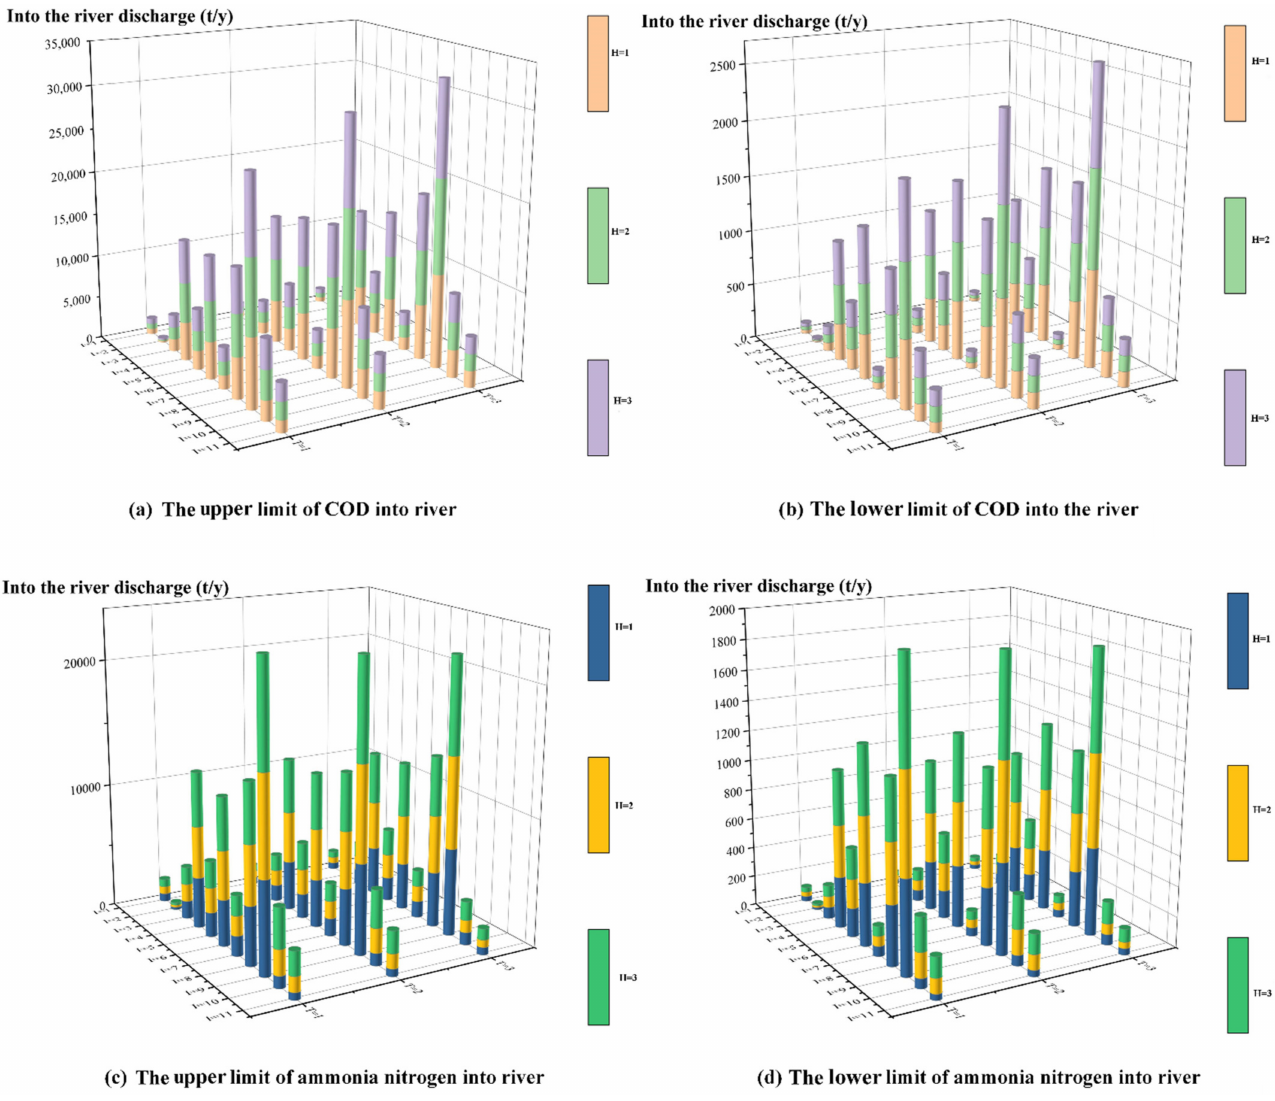
Figure 3. COD and ammonia discharge emissions into the river at each control section in the Yinma River Basin. ( a ) The upper limit of COD into river at each control section in the Yinma River Basin ( b ) The lower limit of COD into river at each control section in the Yinma River Basin ( c ) The upper limit of ammonia nitrogen into river at each control section in the Yinma River Basin ( d ) The lower limit of ammonia nitrogen into river at each control section in the Yinma River